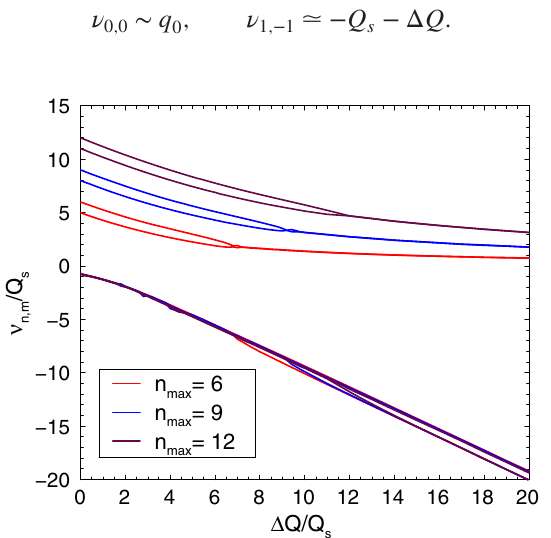
FIG. 7. The most important spectral lines in different approx- imations. Lower lines, modes f 0 ; 0 g and f 1 ; − 1 g ; upper ones, the highest observed tunes allowed by considering